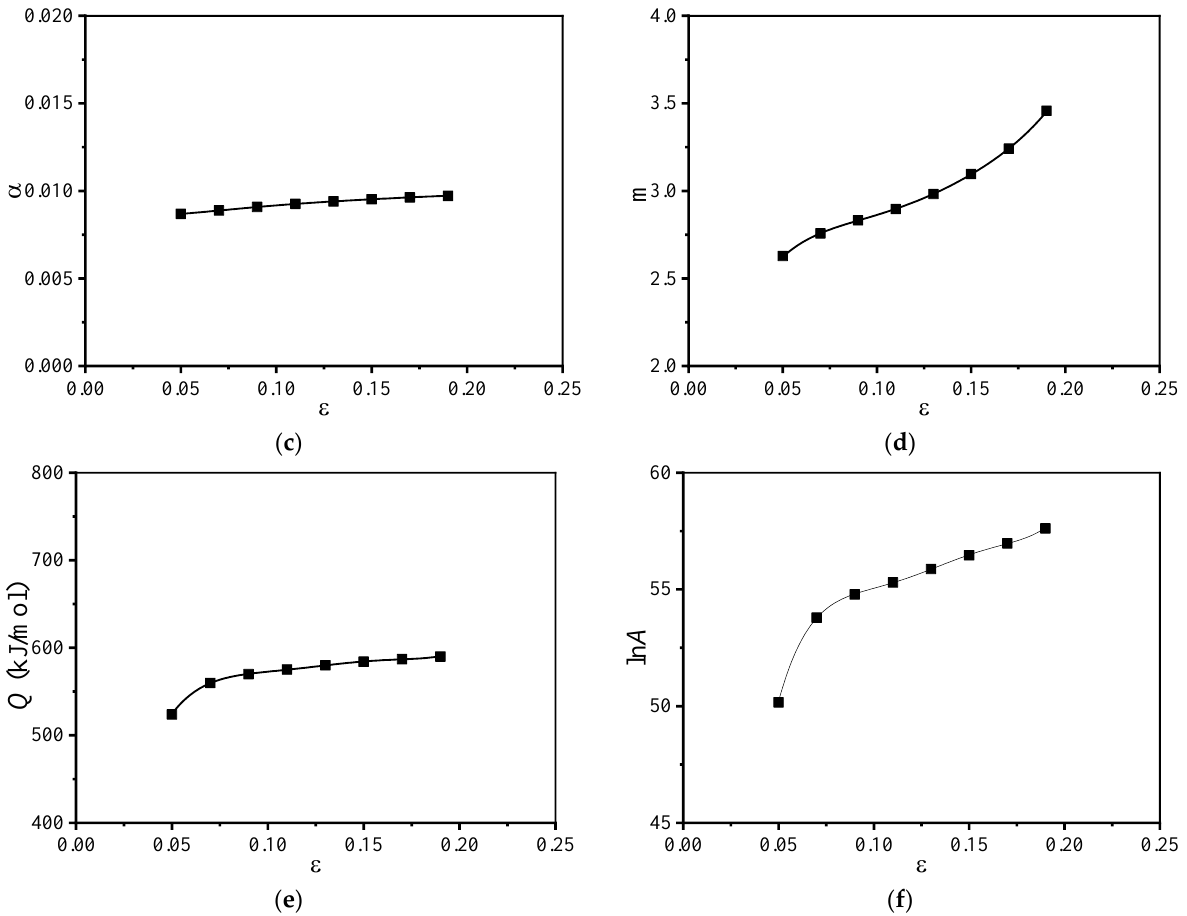
Figure 8. The relationship between the material constant and the true strain: ( a ) n (cid:48) ; ( b ) β ; ( c ) α ; ( d ) n; ( e ) Q; ( f ) lnA. The experimentally obtained values and the model-predicted values obtained under conditions of varying temperatures and were compared to verify the accuracy of the model. The results are presented in Figure 9. When is 0.1 s −1 , a high prediction accuracy is realized, while the prediction accuracy is unacceptable at other strain rates. Therefore, the model does not fully account for the effect of the strain rate, and further modification is needed to accurately describe the behavior of the materials.